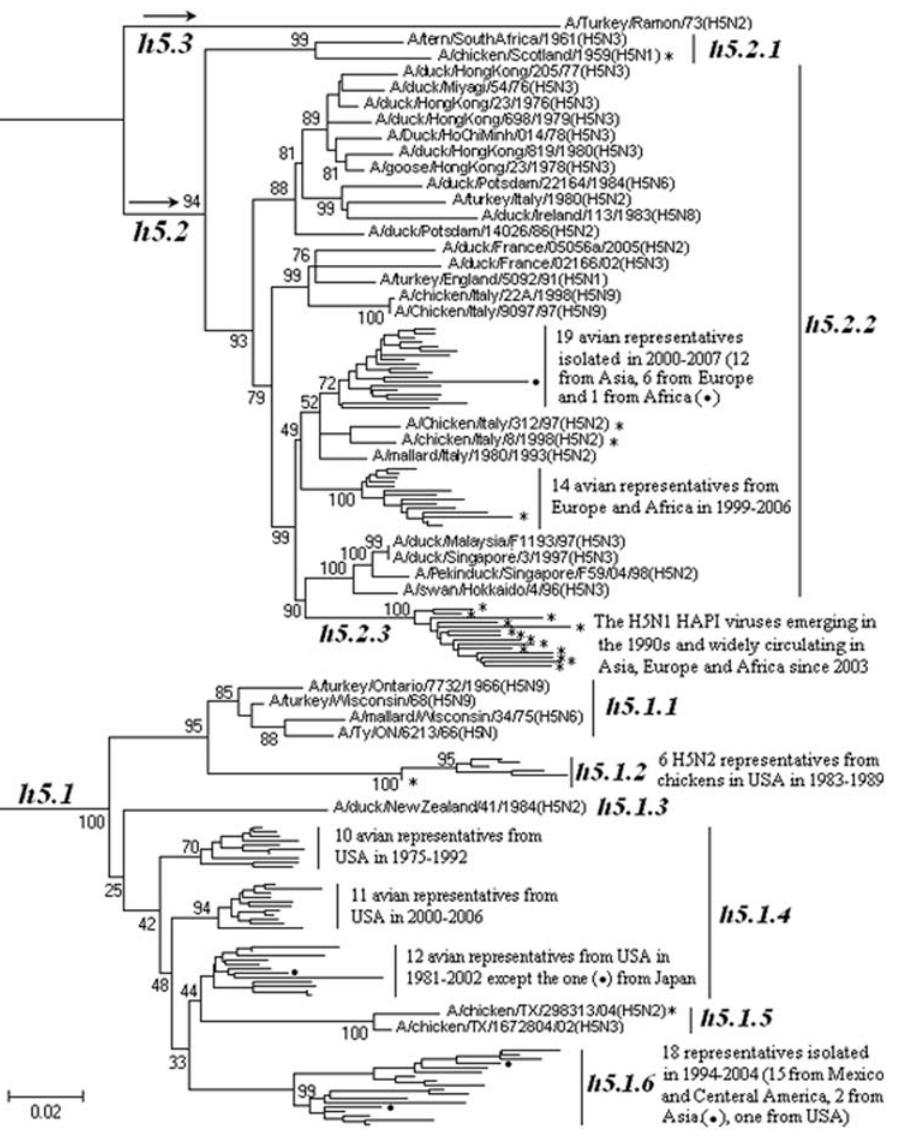
Figure 6. The panorama phylogenetic tree of subtype H5 influenza virus based on the viral HA sequences. The tree suggested that avian H5 influenza viruses isolated from the Western Hemisphere and the Eastern Hemisphere were located in the sublineages h5.1 and h5.2, respectively. The current HPAI H5N1 widely circulating in the Eastern Hemisphere formed a distinct sublineage (h5.2.3) within lineage h5.2 which were partially detailed in Text S2. For space limitation, most representatives within h5.2.3 were not shown in this figure. HPAI viruses were marked with ‘‘*’’. Bootstrap values were given at relevant nodes.